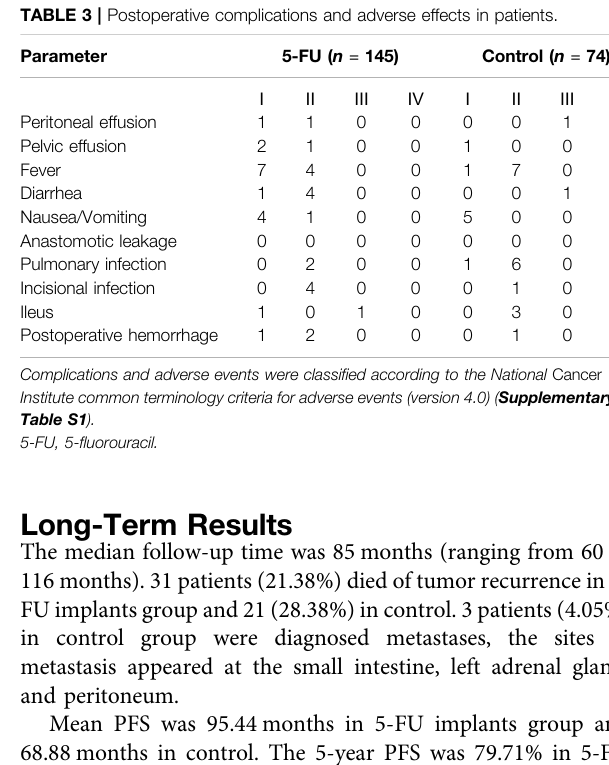
TABLE 3 | Postoperative complications and adverse effects in patients. Parameter